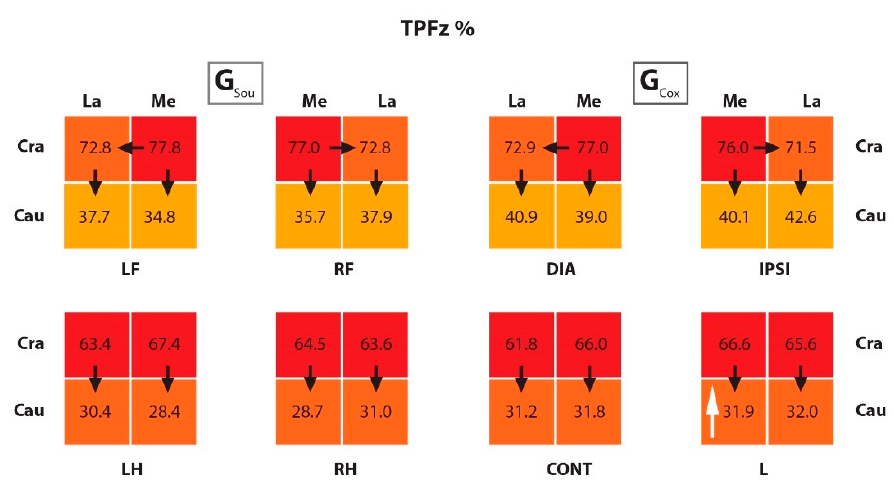
Figure 7. The scheme representing the TPFz% in the quadrants of the paws from G Sou and G Cox . The black arrows show a significant difference between quadrants within paws (for example, in the LF limb from G Sou there was a difference between the CraLa and CraMe quadrants); and the white arrow, between groups (for example, there was a difference between the CauMe quadrants from the RH limb in G Sou and L limb in G Cox );. The color scale within paws: higher values in darker colors and lower values in lighter colors. TPFz% (time of occurrence of peak of vertical force as a percent of the stance phase duration); G Sou (group sound); G Cox (group coxarthrosis); LF (left front limb); RF (right front limb); LH (left hind limb); RH (right hind limb); DIA (diagonal limb); IPSI (ipsilateral limb); CONT (contralateral limb); L (lame limb); Cra (cranio); La (lateral); Cau (caudo); Me (medial).